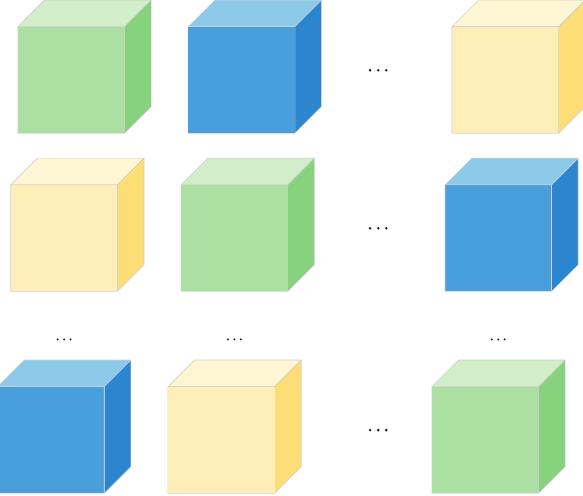
Figure 3: Five-dimensional matrix